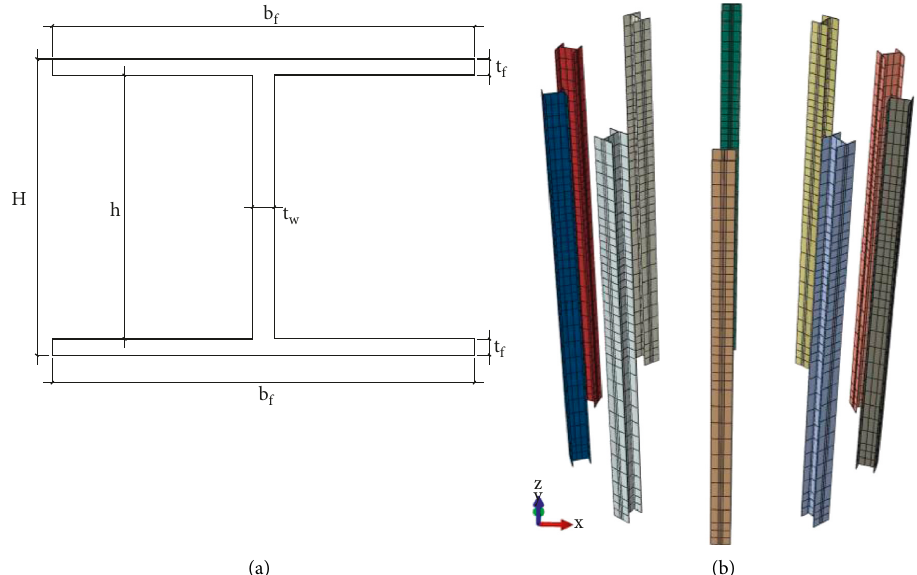
Figure 4: Cross section dimensions and distribution of the H section steel. (The total height H was 1m; and the height of web h is 0.98m; and the thickness of web t w is 0.01 m; and the flange width b f is 1.0m; and the flange thickness t f is 0.01m). (a) Dimensions of cross section of H- bar steel. (b) H-bar steel annular distribution.